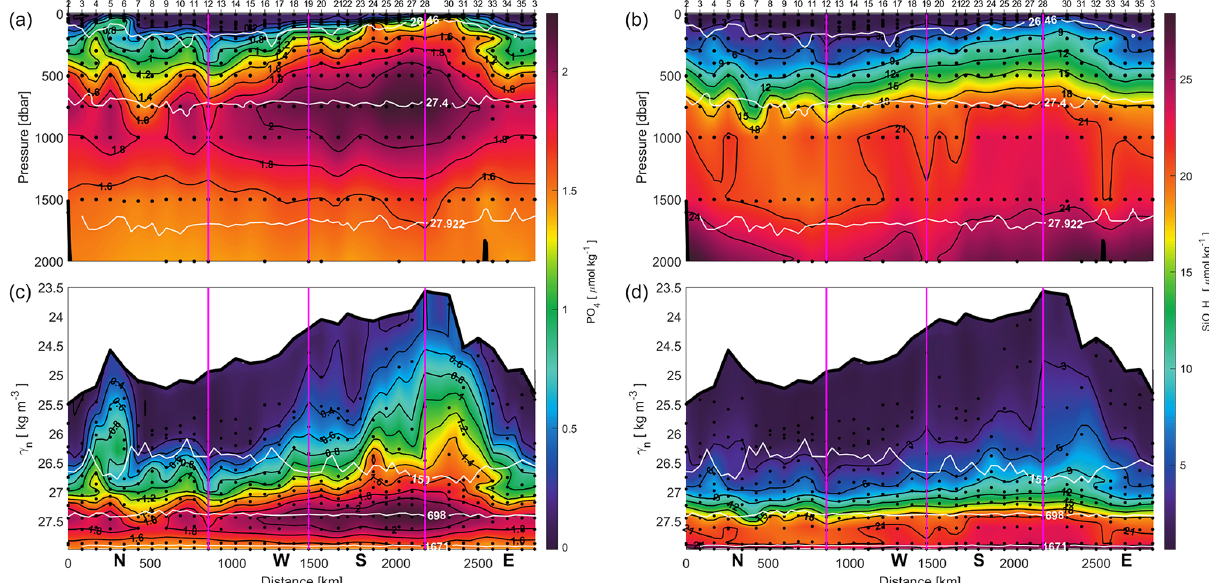
Figure 7. Sections of PO 4 (a, c) and SiO 4 H 4 (b, d) with respect to depth (upper line) and γ n (lower line) during the FLUXES-I cruise. The direction chosen for the representation is the same as in Fig. 3. The northwestern, southwestern and southeastern corners are indicated by three vertical pink lines at stations 12, 19 and 28, respectively. In depth sections, the isoneutrals which delimit the surface, central, intermediate and deep water are represented by white contours. In γ n sections, the depths of 150, 698 and 1671m are also shown. The sampling points of PO 4 and SiO 4 H 4 used in this work are represented by black